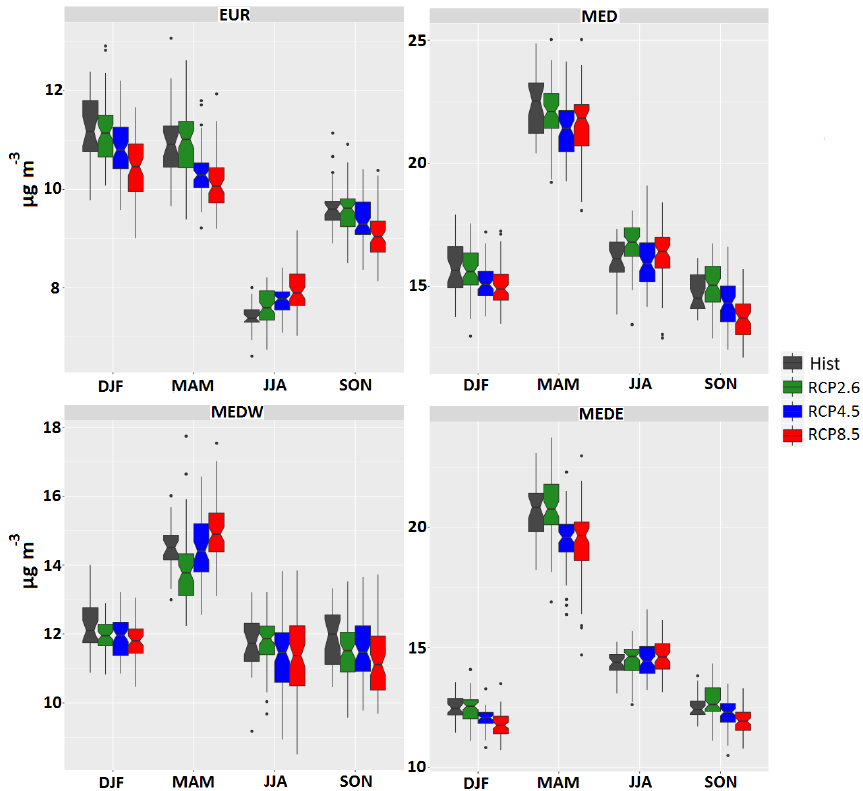
Figure 6. Seasonal box plots for all scenarios for all seasons for PM 10 (historic simulations are black, RCP2.6 is green, RCP4.5 is blue and RCP8.5 is red) for the different subdomains. Scales are different for different